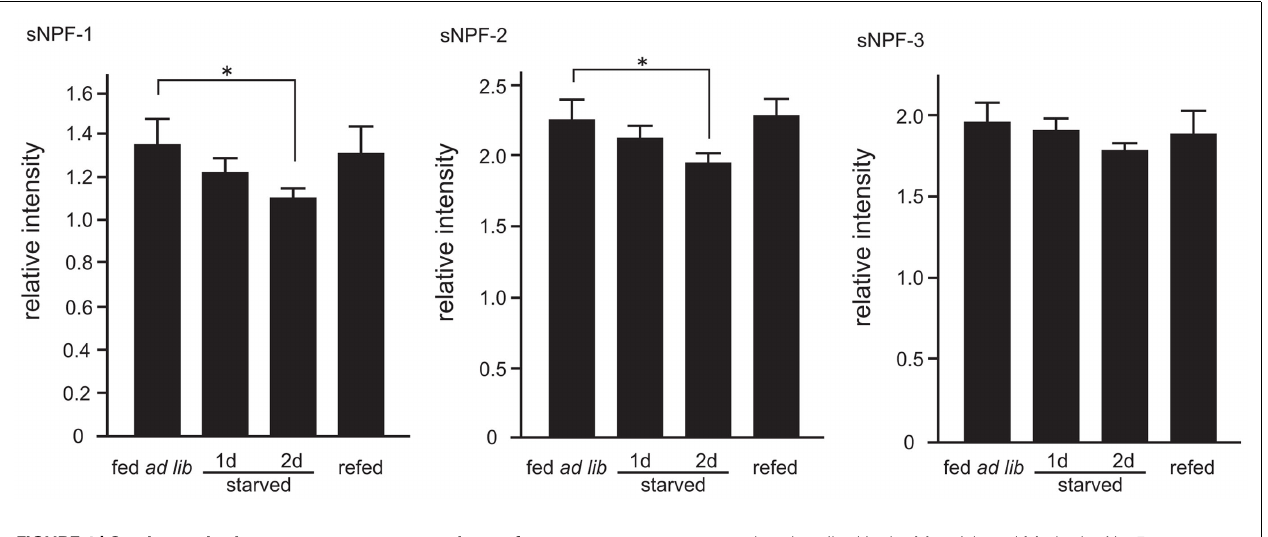
FIGURE 4 | Semi-quantitative mass spectrometry analyses of sNPFs. The sNPFs levels were measured by comparing with an exogenous nonsense peptide. Samples were prepared from 2-day-old fifth instar larvae. Larvae were starved for 1 and 2days. Re-fed-larvae